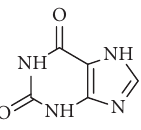
Figure 1: Structure of